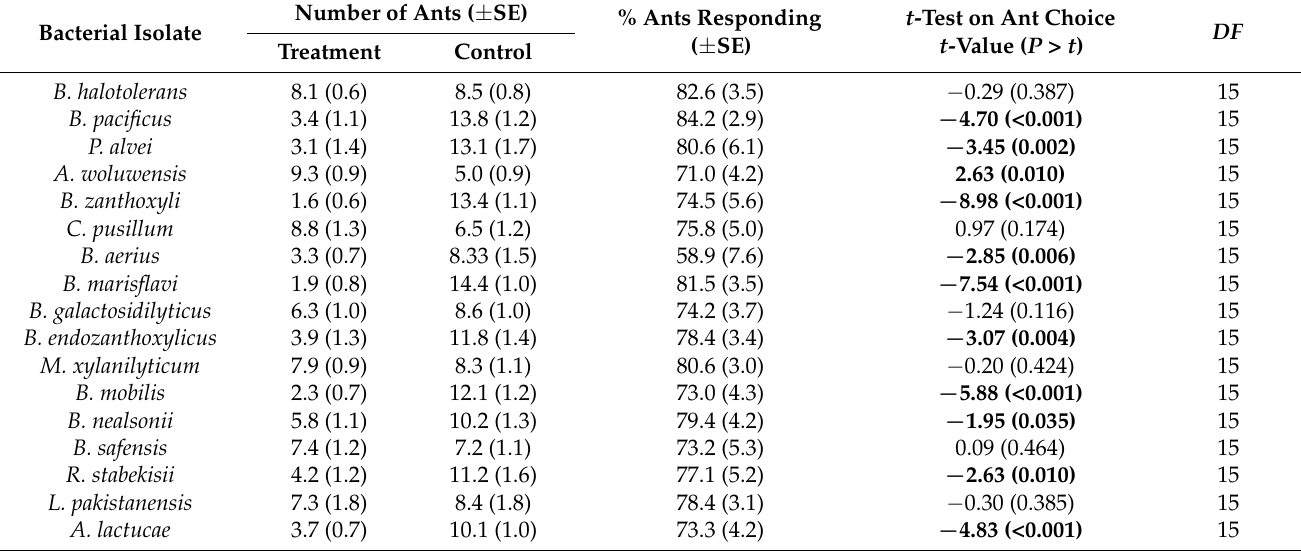
Figure 2. Phylogenetic tree reconstructed by the maximum likelihood method (Tamura-Nei model) based on 16S rRNA gene sequences showing the phylogenetic relationship between bacteria cultured from Solenopsis invicta nest soils. Bootstrap percentage values (based on 500 replications) with 50% cutoff value are shown at the nodes. Phylum-level groupings indicated on right. Table 2. Effects of soil-derived bacterial isolates on S. invicta residing preferences after 18 h. Bacterial